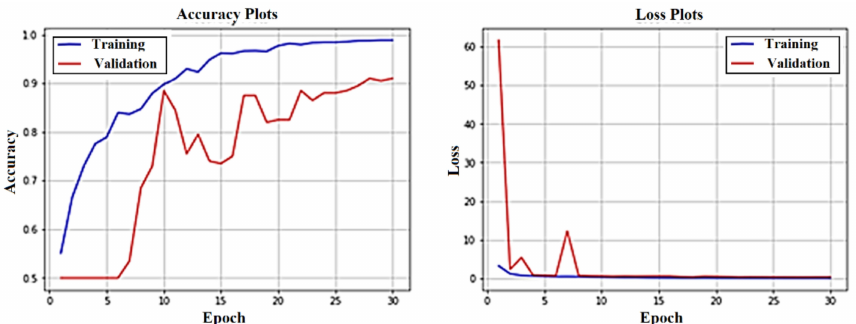
Figure 9. Accuracy and loss plots of Xception.